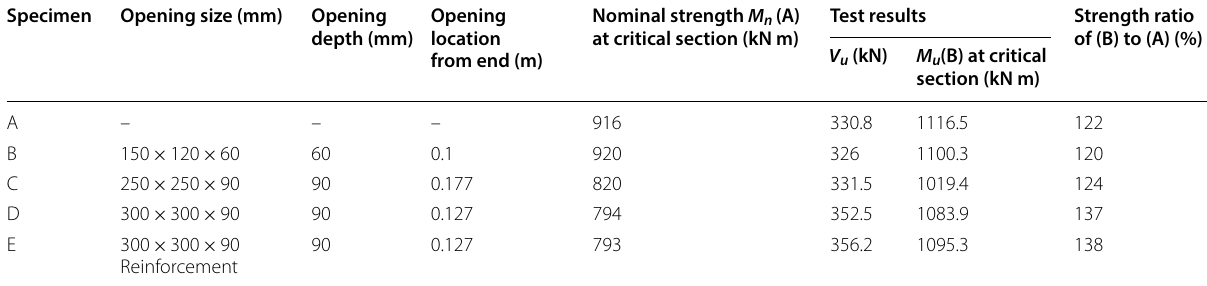
Table 4 Analysis of test results.